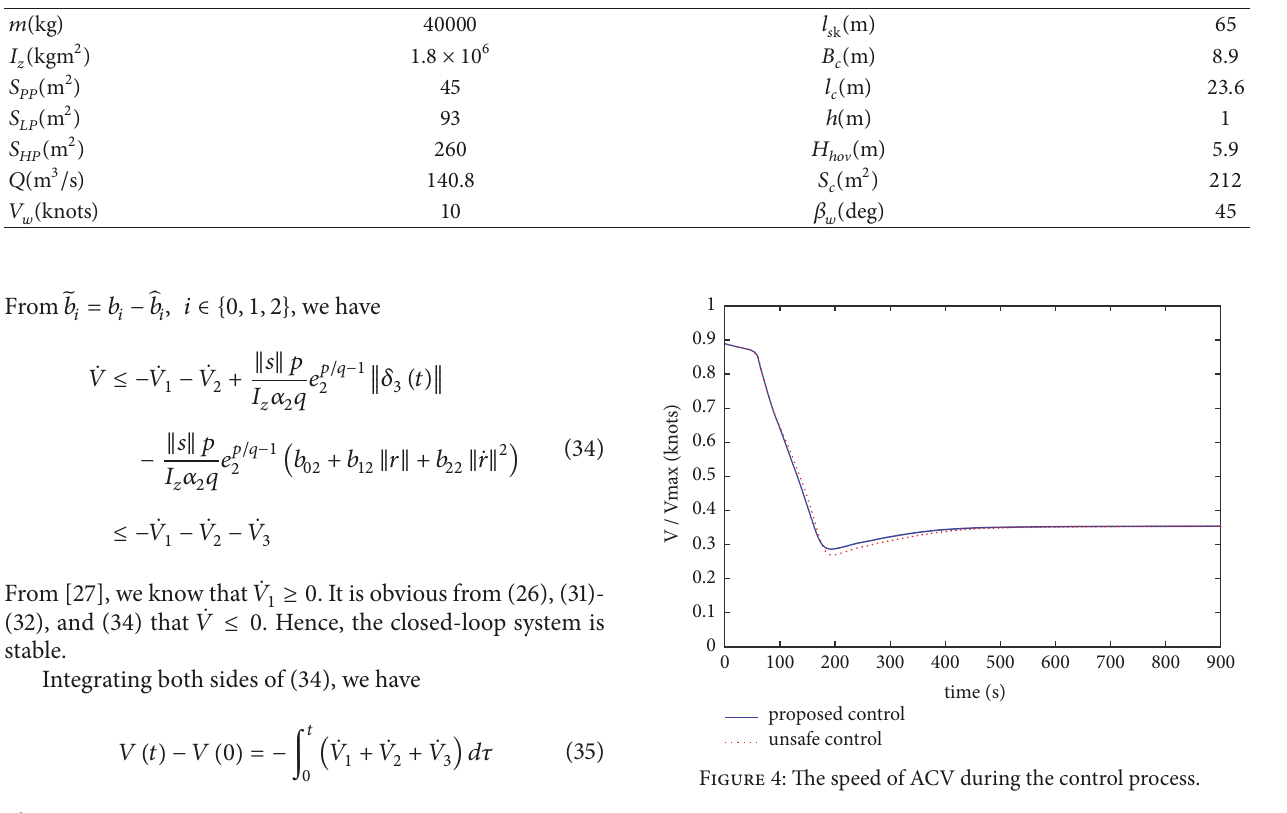
Table 1: Main particulars of hovercraft.